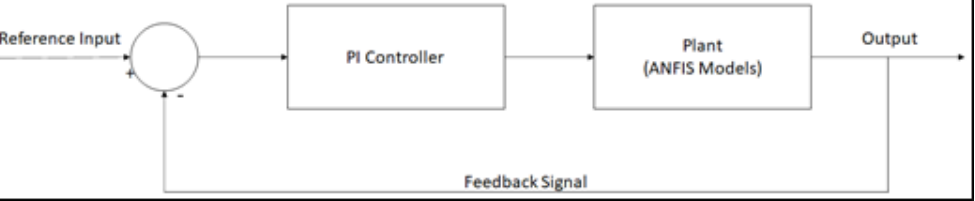
Figure 7. PI control scheme.